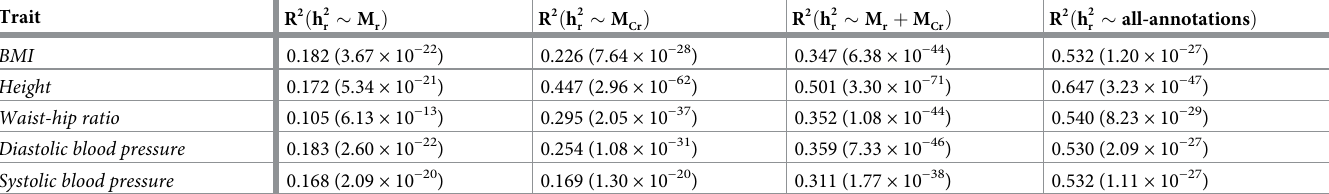
In the first column, we model the linear relationship between the heritability of a trait and the number of SNPs across all regions of the genome. We report the coefficient of determination ( R 2 ). The relationship is significant for all traits ( p -values are reported in parentheses). We observe a similar trend relating the heritability and number of causal SNPs in a region. We perform a multivariate regression to assess the relationship between the heritability and both the number of SNPs and number of causal SNPs in a region. Finally, in the last column, we perform a multivariate regression of heritability on the number of SNPs, number of causal SNPs, number of genes, median B value, and functional annotations [28]. Significant annotations are listed in Table B in S1